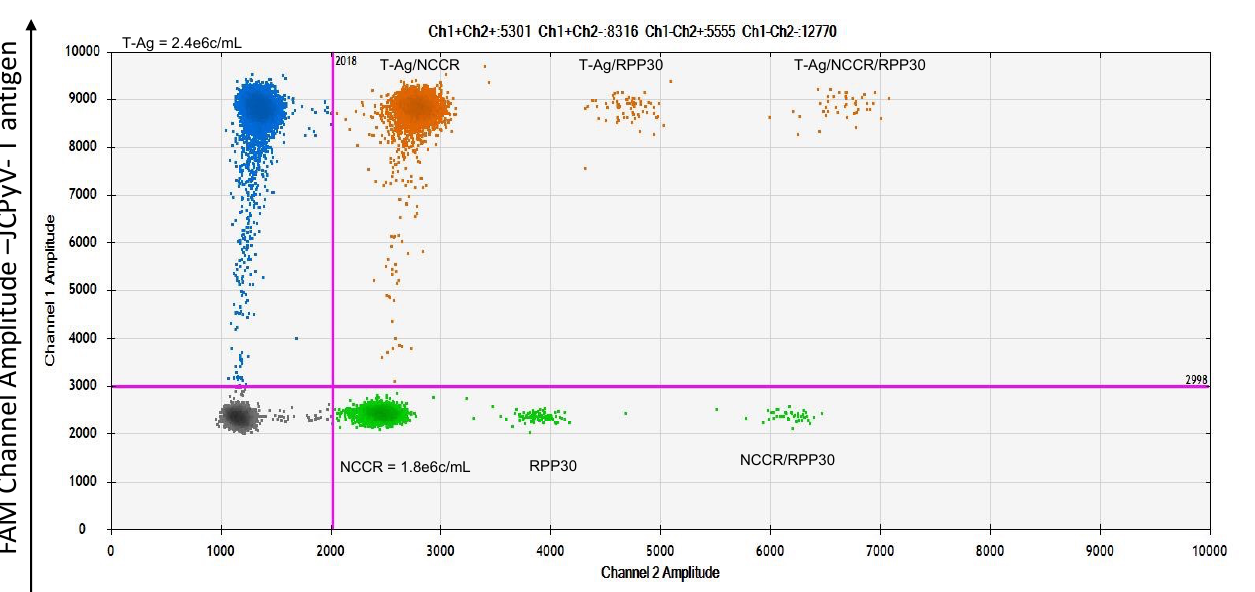
Figure 4. Representative two-dimensional plot of triplex ddPCR. Urine sample from a PML patient used as positive control. Primer sets and fluorescent probes to detect a conserved sequence in the JCPyV large T antigen FAM (y-axe; upper left quadrant; blue droplets) and a unique sequence of JCPyV-NCCR VIC for the archetype variant (x-axe; lower right quadrant; green droplets) and RPP30 VIC, housekeeping gene (x-axe; lower right quadrant; green droplets). By differing the primers/probe concentrations, RPP30 (20x) and NCCR (5x) could be used simultaneously on the VIC channel. Populations double positive for T-Ag, NCCR and RPP30 are in the upper right quadrant (orange droplets) and in the lower right quadrant (green droplets).